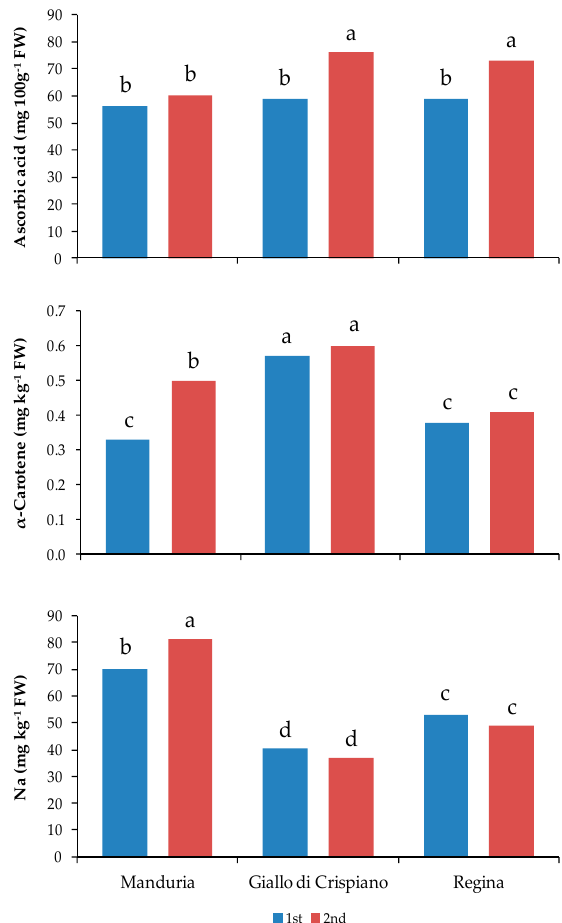
Figure 3. Content of ascorbic acid ( p ≤ 0.01), α -Carotene ( p ≤ 0.05) and sodium ( p ≤ 0.05) in tomato fruits of three genotypes at two harvest time: (1st) 7th, 14th and 20th July 2016, respectively for Manduria, Regina and Giallo di Crispiano; (2nd) 14th and 20th July and 4th August 2016, respectively for Manduria, Regina and Giallo di Crispiano. Di ff erent letters indicate significant di ff erences at p = 0.05. Table 5. Main e ff ects of genotype and harvest time on carotenoids and tocopherols of tomato fruits.